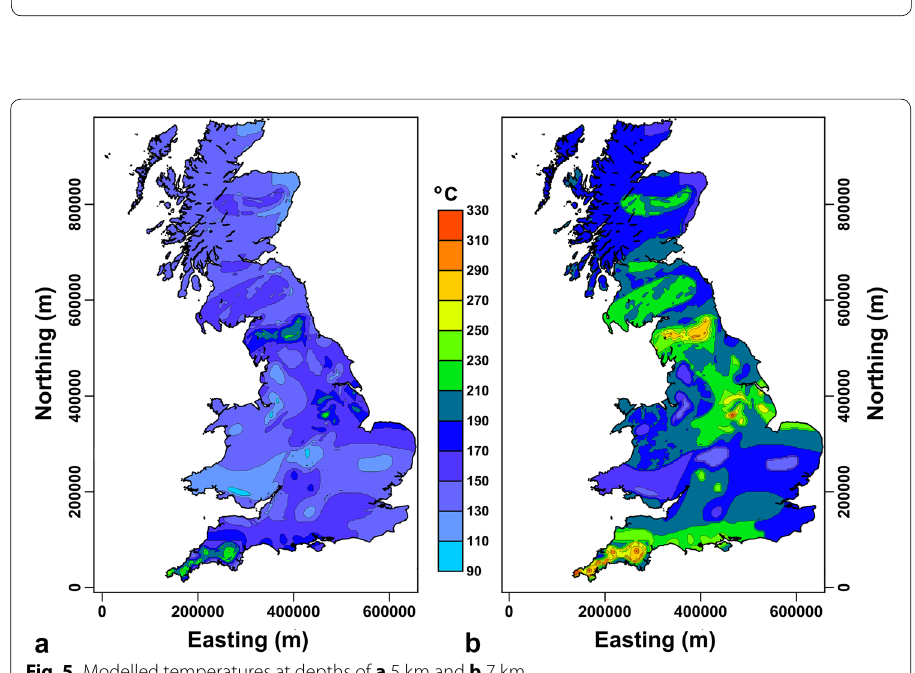
Fig. 5 Modelled temperatures at depths of a 5 km and b 7